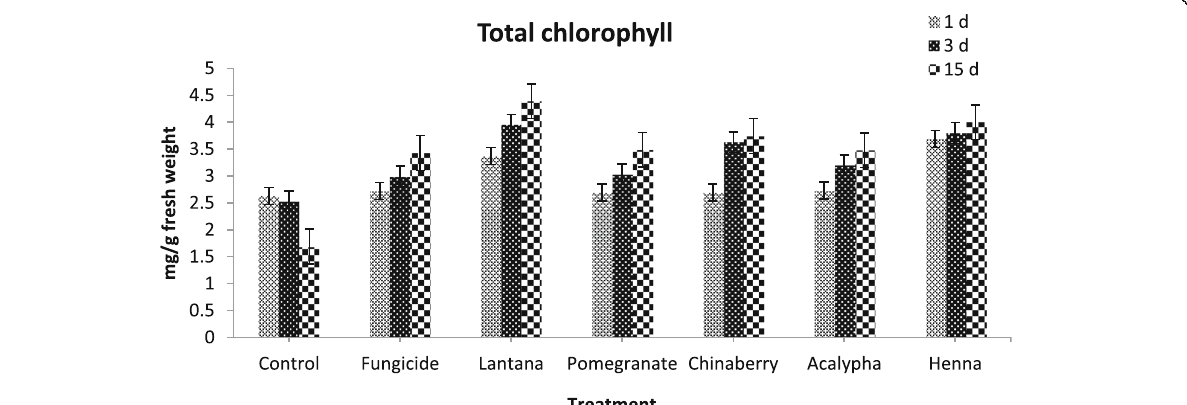
Fig. 1 Effect of some plant extracts on the total chlorophyll (a + b) contents of wheat leaves cv. “ Gemmeiza-7 ” infected with Puccinia triticina , as compared to the fungicide Fungshow